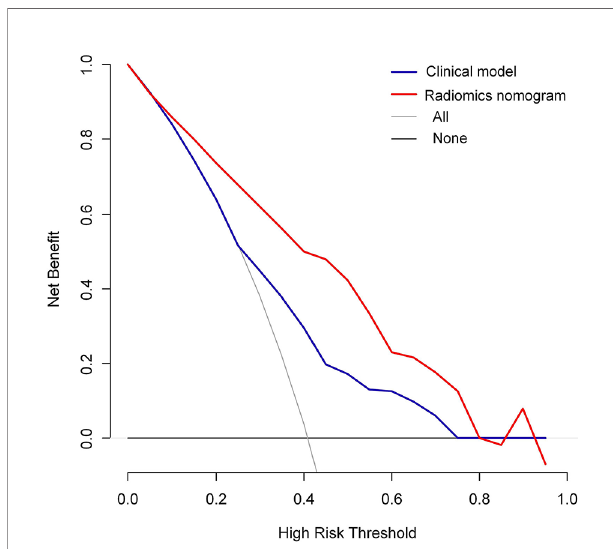
FIGURE 4 | Decision curve analysis (DCA) of the radiomics nomogram and clinical model in predicting the MVI status for hepatocellular carcinoma derived from the all 313 patients.